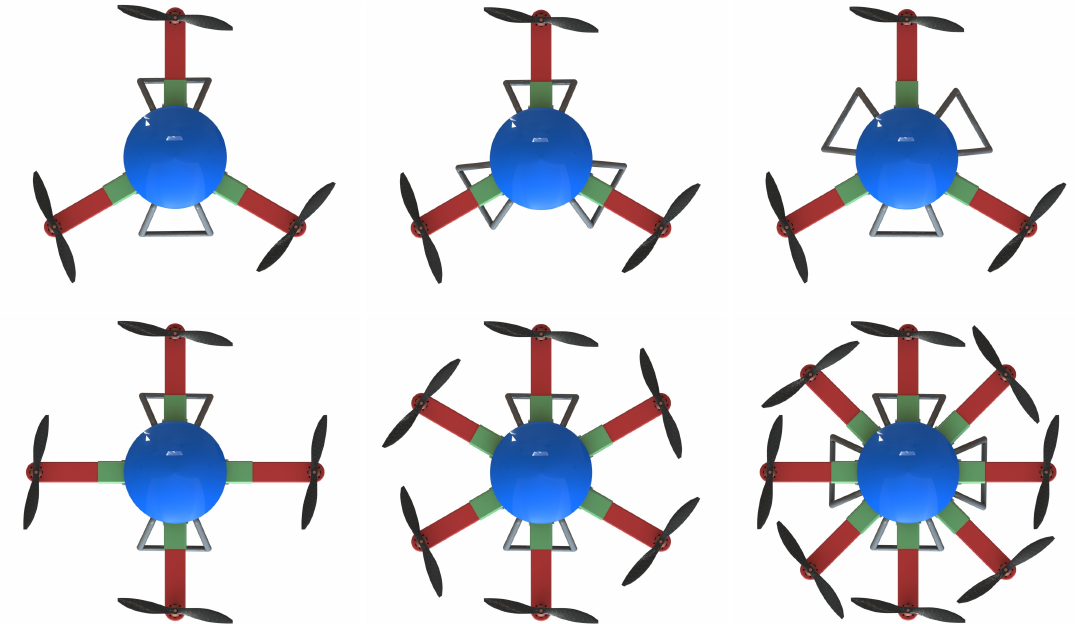
Figure 7: Several leg inclusions depending on the chosen